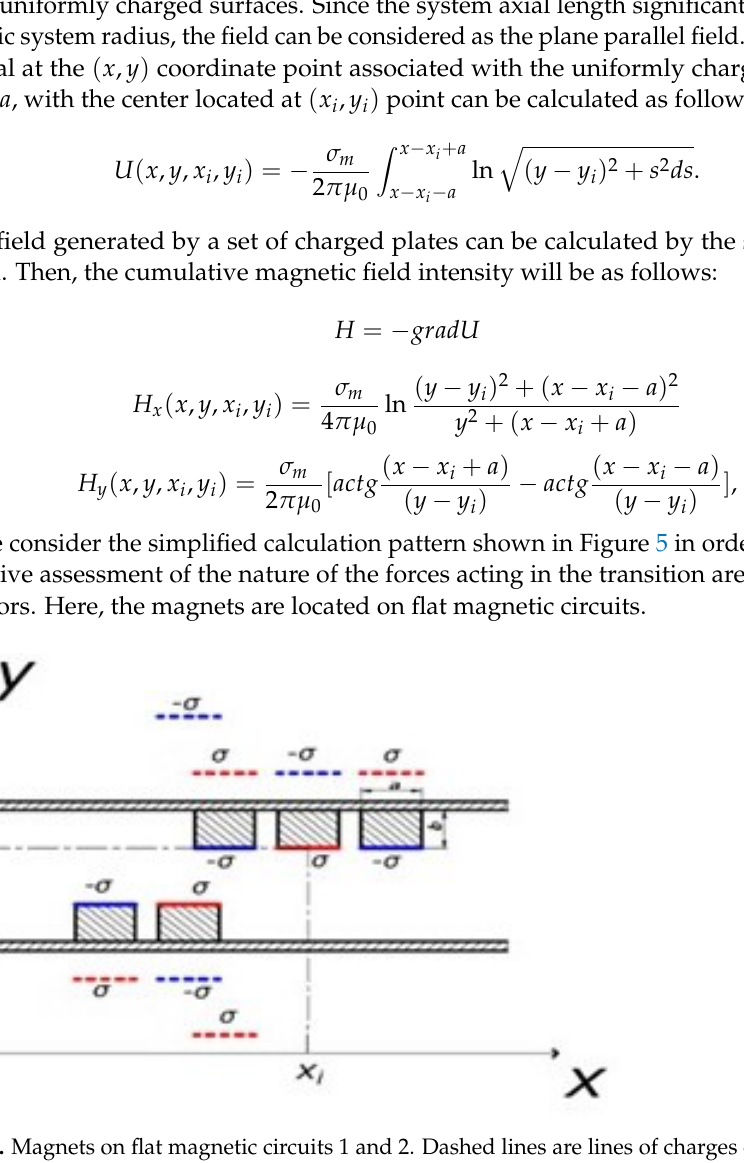
Figure 5. Magnets on flat magnetic circuits 1 and 2. Dashed lines are lines of charges of opposite sign specularly reflected from isopotential